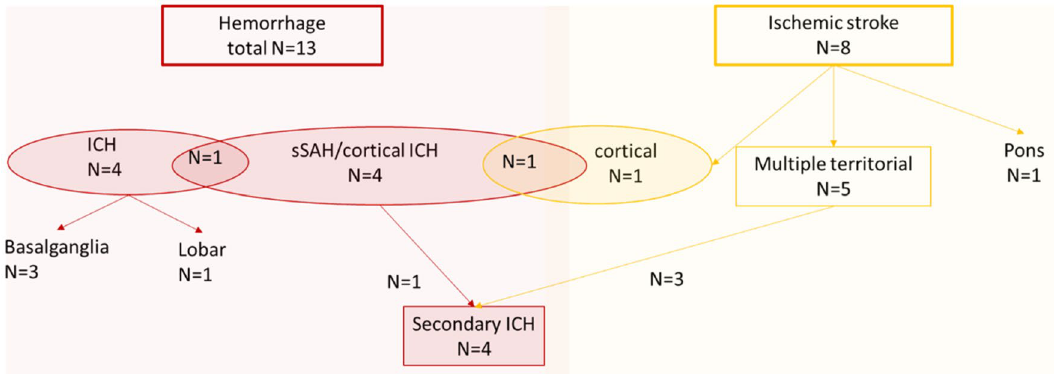
Figure 4. Flow chart of the neuroimaging findings. Sixty-four patients (15%) developed acute neurological symptoms during their ICU stay and underwent neuroimaging. Among those patients, 17 (27%) showed acute PNIF in one of the imaging modalities during their ICU stay.